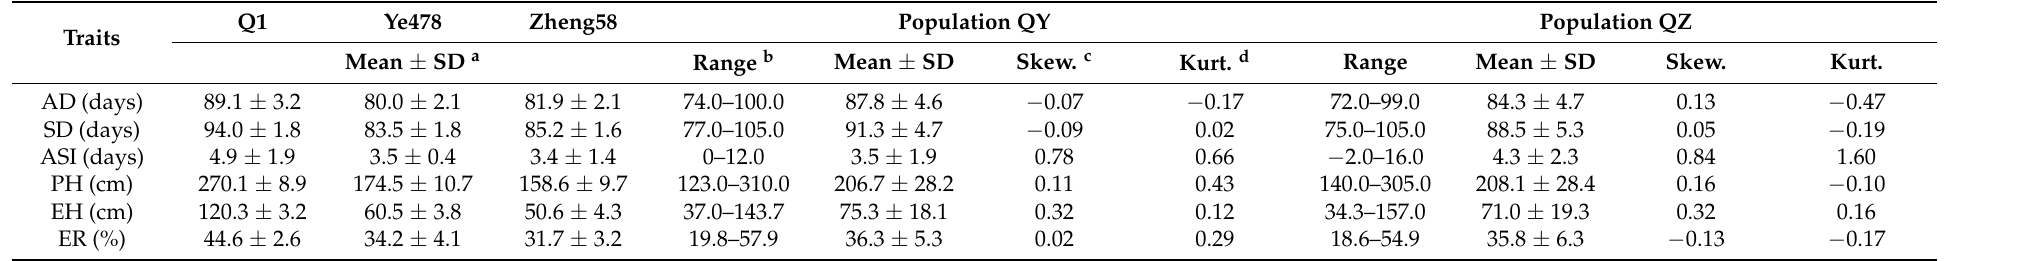
Table 1. Phenotypic summary of the two DH populations and their parents combined with the three